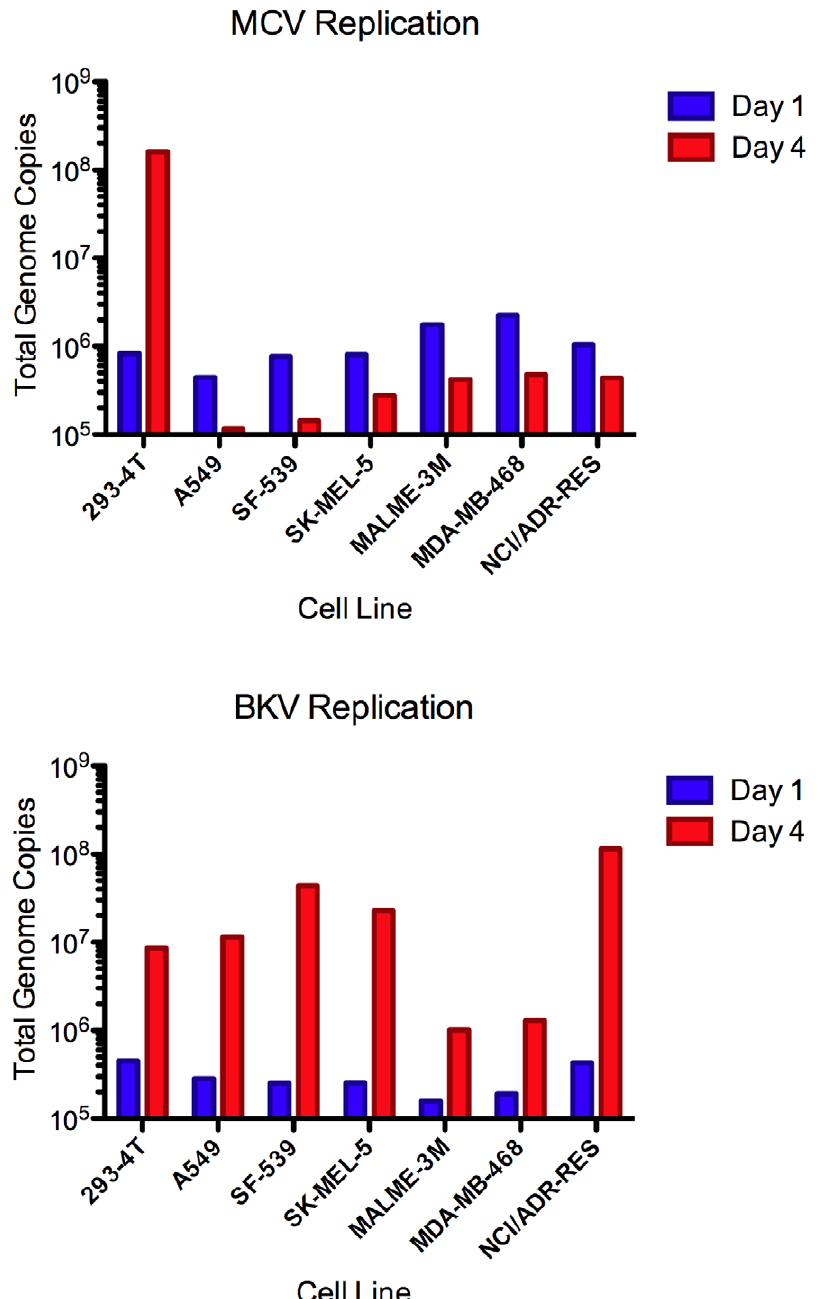
Figure 3. Replication of Native MCV and BKV in infected NCI-60 cells. NCI-60 cell lines with high MCV titers and 293–4 T cells were inoculated with native MCV or BKV in duplicate. The following day, one sample from each cell type was collected and frozen while the other was re- plated. On the fourth day, the second sample was collected. Low molecular weight DNA was purified and the number of MCV or BKV genomic copies was determined by quantitative PCR. One representative experiment of four is shown.